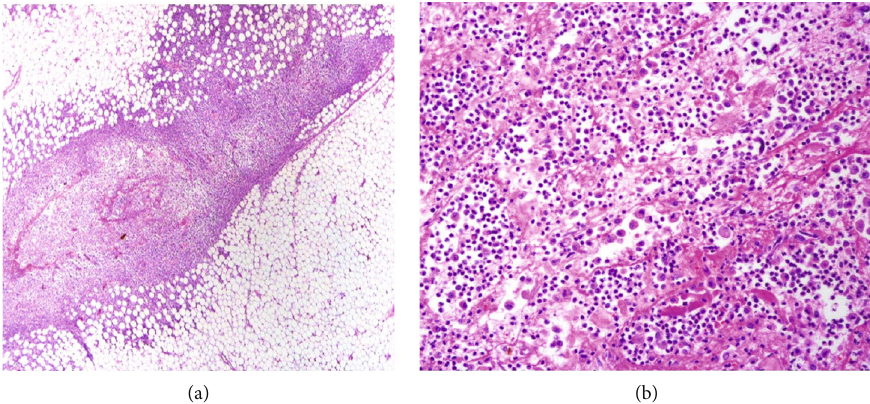
Figure 3: Histopathology micrograph. Intravertebral adipose tissue H&E, region of C6-C8. (a) The intravertebral adipose tissue is variably e ff aced by in fl ammation, fi brin, and necrosis. (b) Higher magni fi cation view of the in fl ammation revealed an in fi ltrate composed of large numbers of neutrophils and macrophages admixed with abundant fi brin. No pathogens were noted.